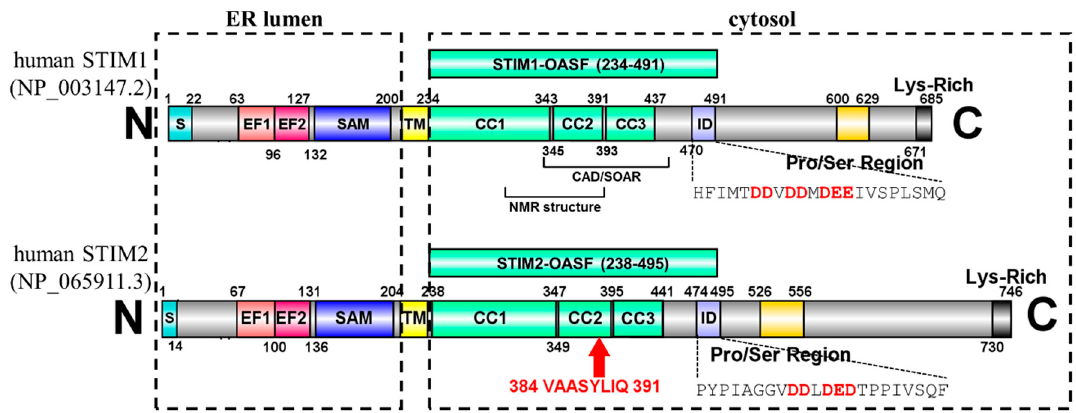
Figure 1. Human stromal interaction molecule (STIM1) and (STIM2) domain architecture. The residue ranges encompassing each conserved domain are indicated. The Orai-activating STIM fragment (OASF) constructs used in the present work are shown above the full-length architectures. The relative locations of the CRAC activating domain (CAD)/STIM-Orai activating region (SOAR) and the CC1-CC2 NMR structure fragment are indicated below the STIM1 architecture. The location of the 2 β insert in the CC2 region of STIM2 is highlighted. The acidic residues found in the ID sequences are shown in red text. S, signal peptide; EF1, canonical EF-hand; EF2, non-canonical EF-hand; SAM, sterile α -motif; TM, transmembrane; CC1, coiled-coil-1; CC2, coiled-coil-2; CC3, coiled-coil-3; ID, inhibitory domain; N, amino terminus; C, carboxyl terminus.